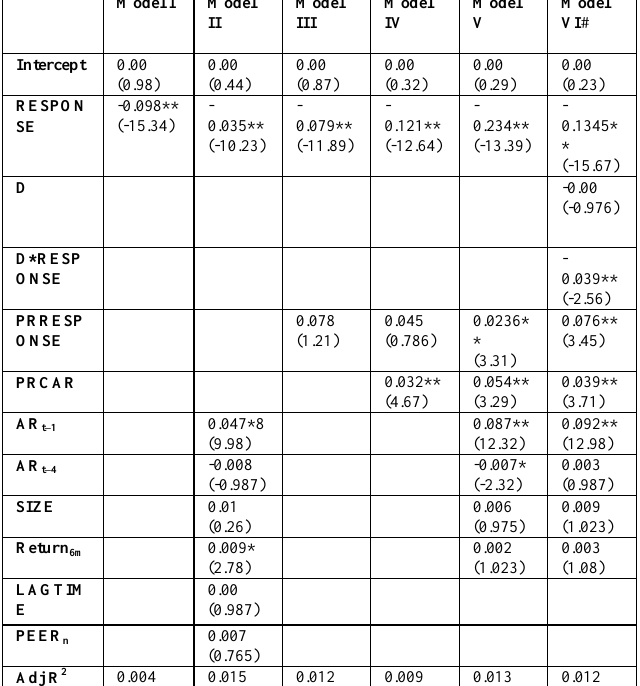
Table 12. Deciles Based Ranking on Firm i’s over reaction (CAR) to Early